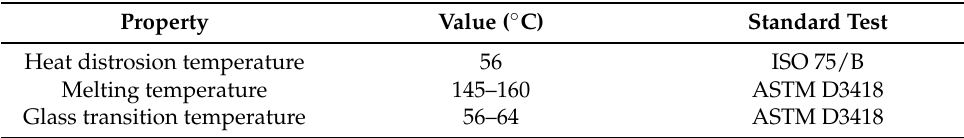
Table 1. Thermal properties of the applied PLA material.